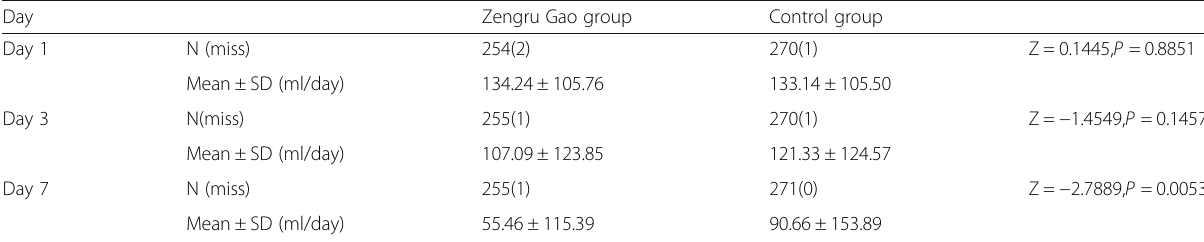
Table 3 Comparison of baby ’ s daily formula intake at day 1, day 3, and day 7 between groups randomized to Chinese herbal medicine Zengru Gao and no intervention Day Zengru Gao